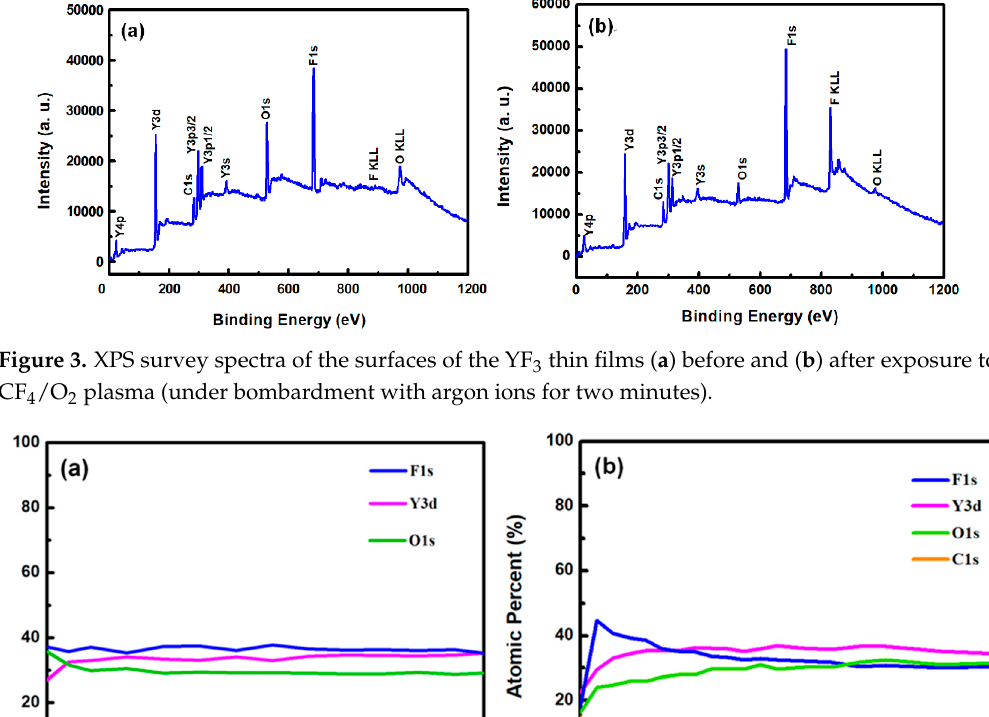
Figure 2. TEM microstructure and selected area diffraction (inset) of YF 3 film.